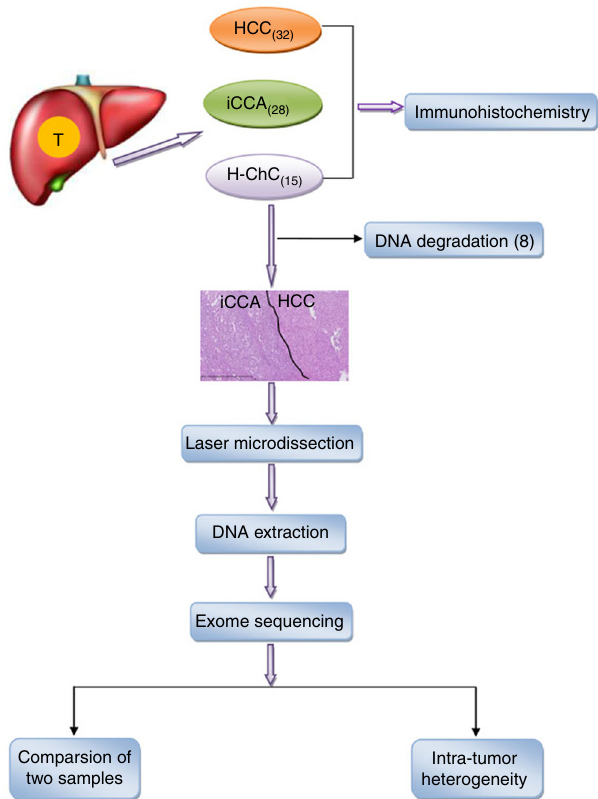
Fig. 1 Flowchart of patient selection and experimental procedure. A total of 32 hepatocelluar carcinoma (H-ChC), 28 cholangiocarcinoma (iCCA), and 15 hepato-cholangiocarcinoma (H-ChC) were selected for immunohistochemistry. The blackline in the pathological picture of